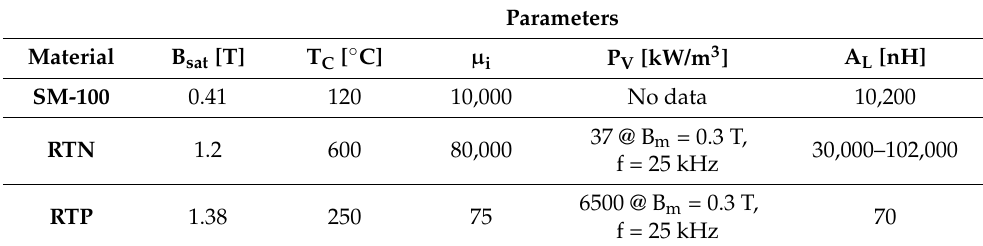
Table 1. Selected material parameters of the used ferromagnetic cores.